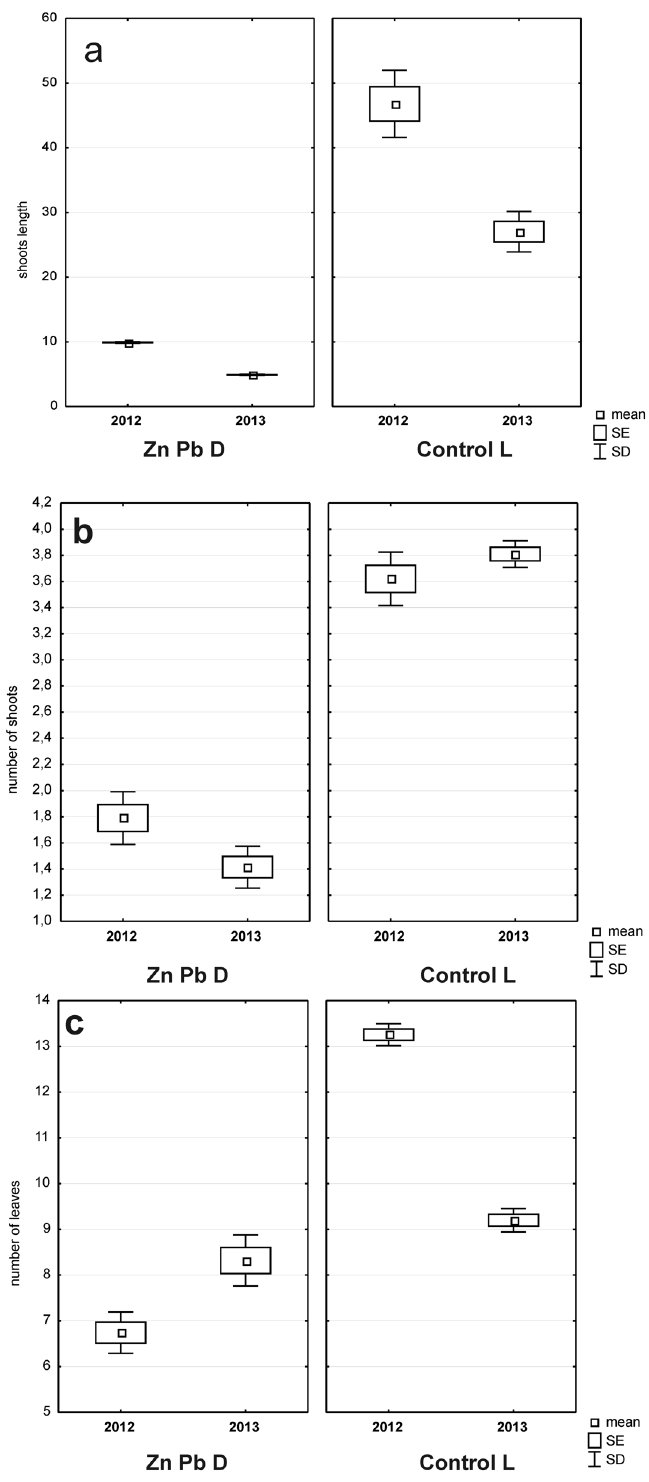
Figure 4. Comparison of the length of the birch seedling shoots ( a ), the number of birch seedling shoots ( b ), the number of birch seedling leaves ( c ) from the Zn-Pb D and Control L sites during two vegetative